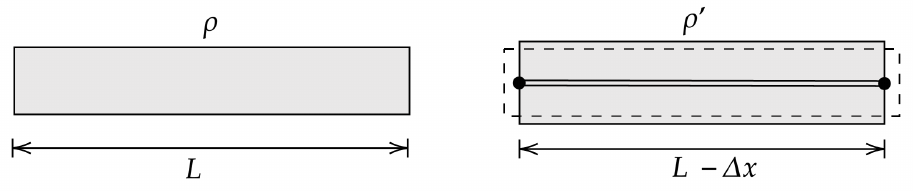
Figure 2. Effect of axial compression in volume